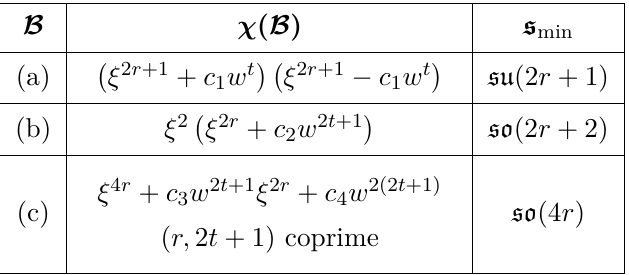
Table 2 . Irreducible blocks and minimal